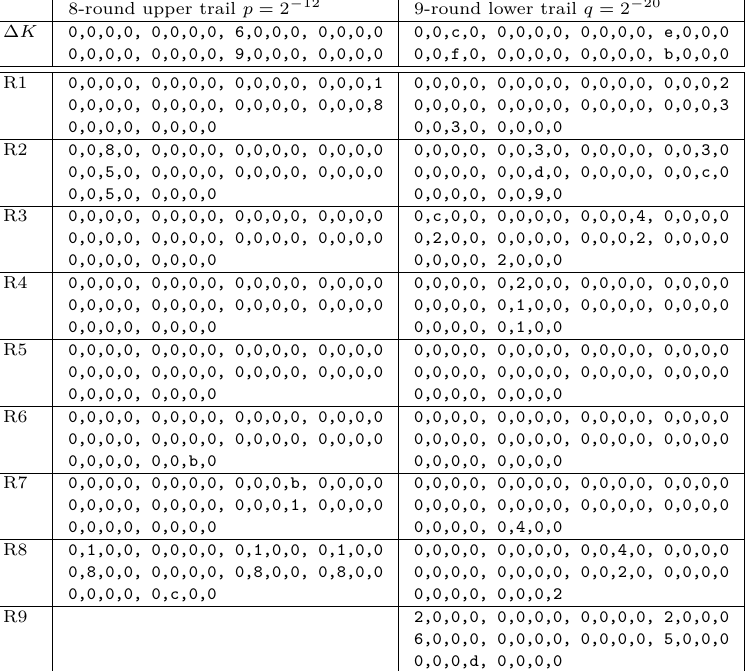
Table 7: Differential trails of SKINNY-64-128